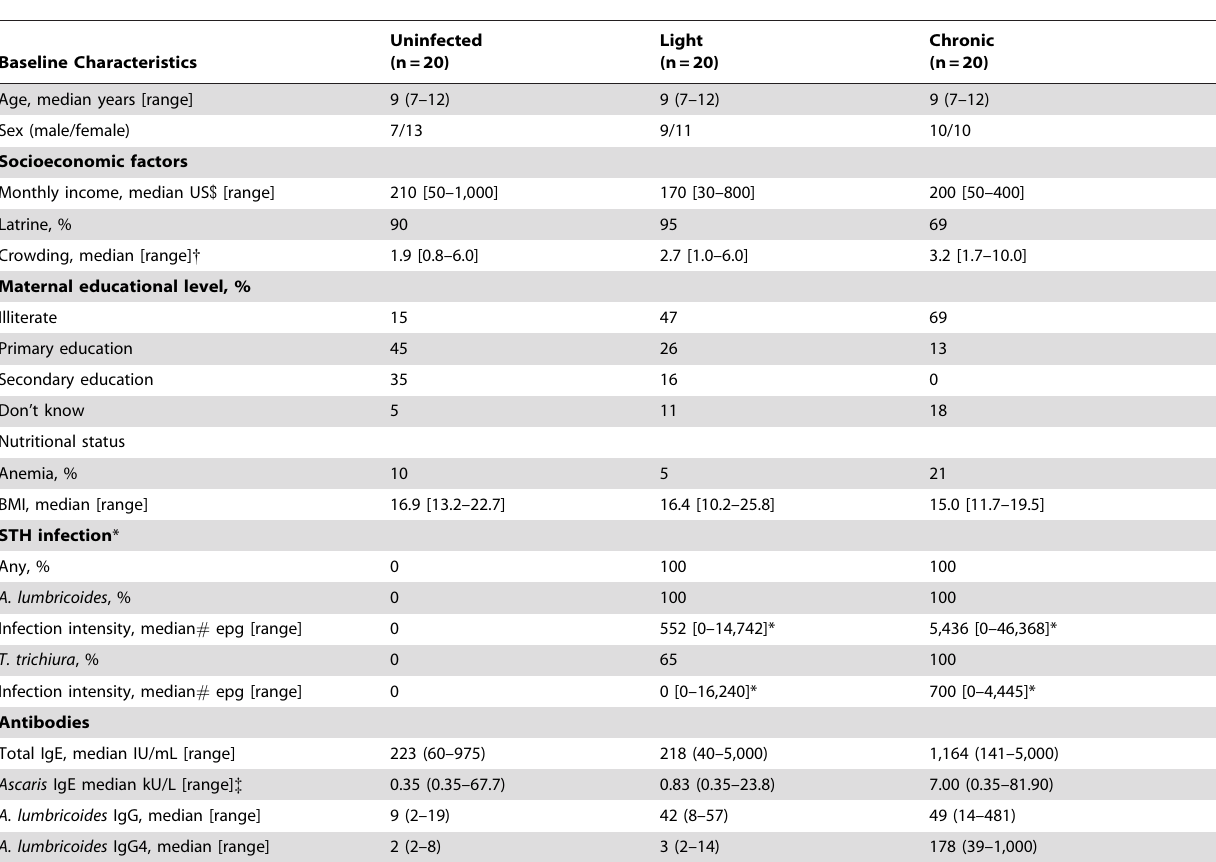
Table 1. Baseline characteristics of the 3 infection